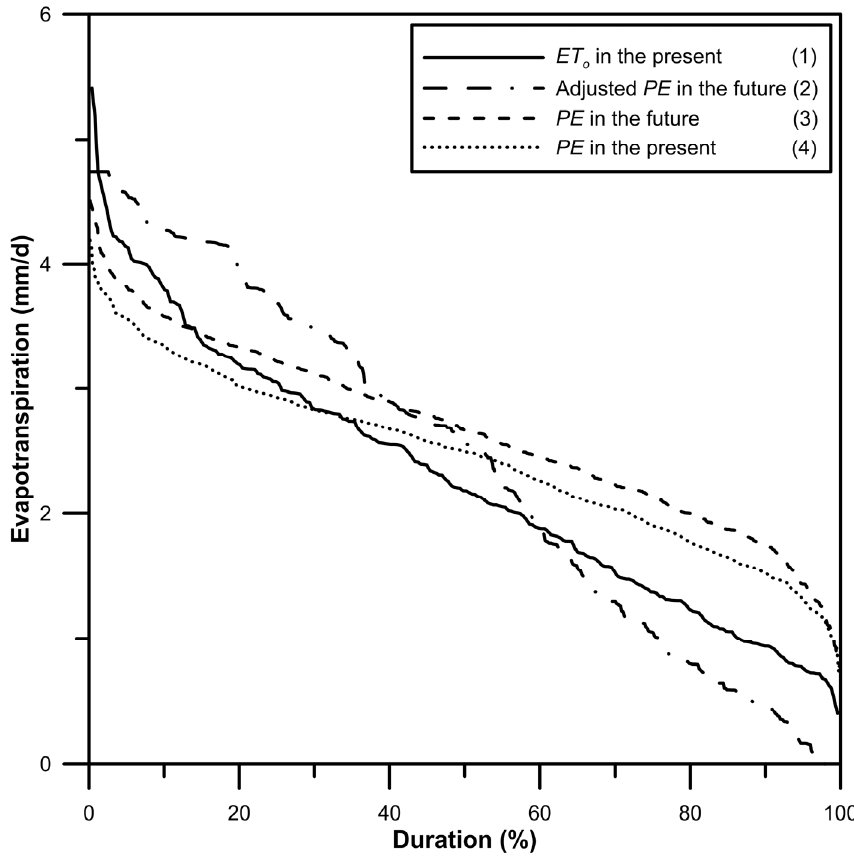
Figure 7. Comparison of duration curve for evapotranspiration at each quadrant in March (LASG